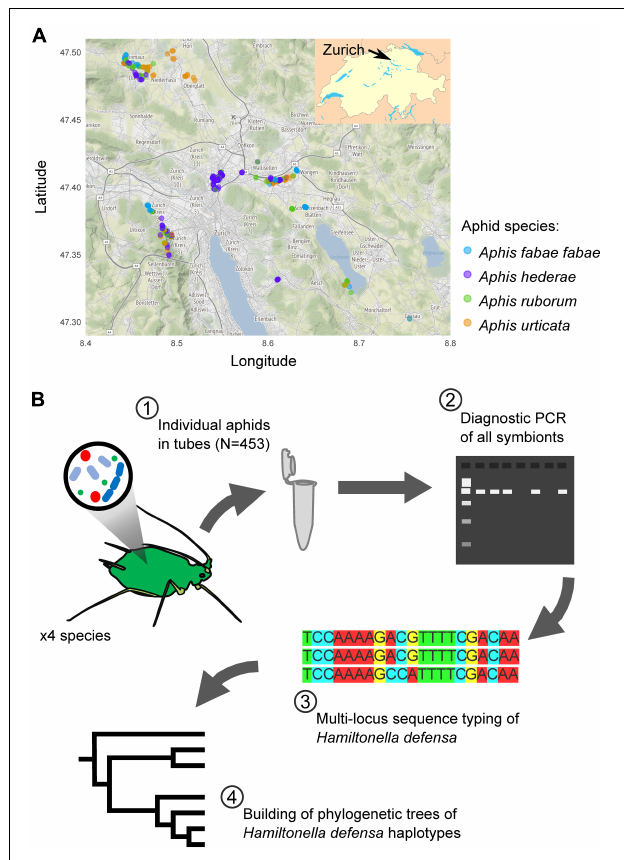
FIGURE 1 | Sampling map of the aphids (A) and overview of the experimental plan (B) . In (A) , each dot corresponds to a single sample, with the color indicating the aphid species. Map tiles by Stamen Design, under CC BY 3.0. Data by OpenStreetMap, under ODbL.